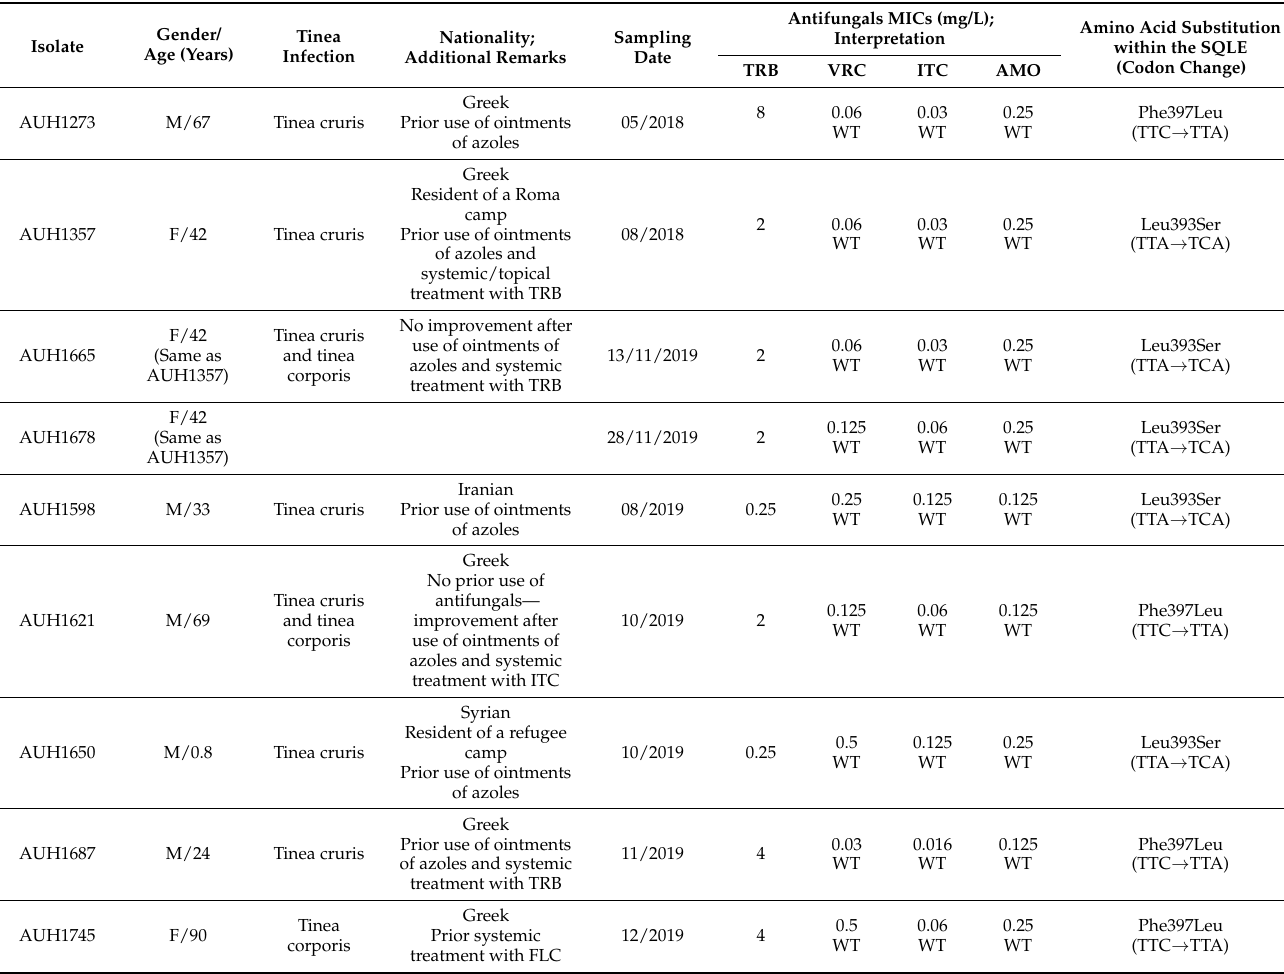
Table 2. Overview of the patients with dermatophytosis due to T. mentagrophytes ITS Type VIII exhibiting reduced susceptibility to